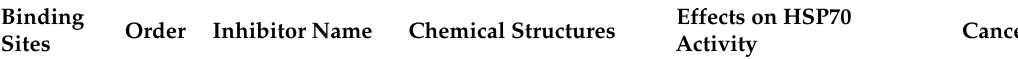
Table 1. Preclinical studies of HSP70 inhibitors in cancer therapies.